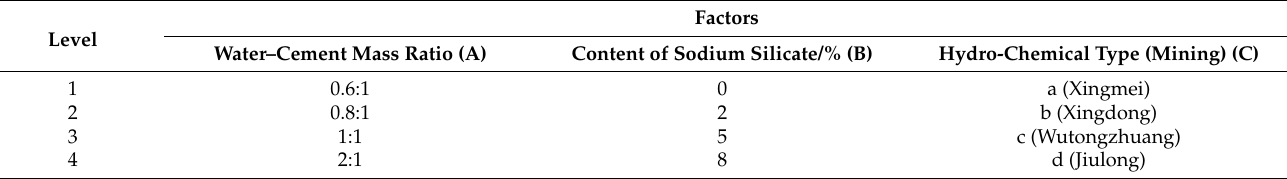
Table 3. Test factors and levels of cement